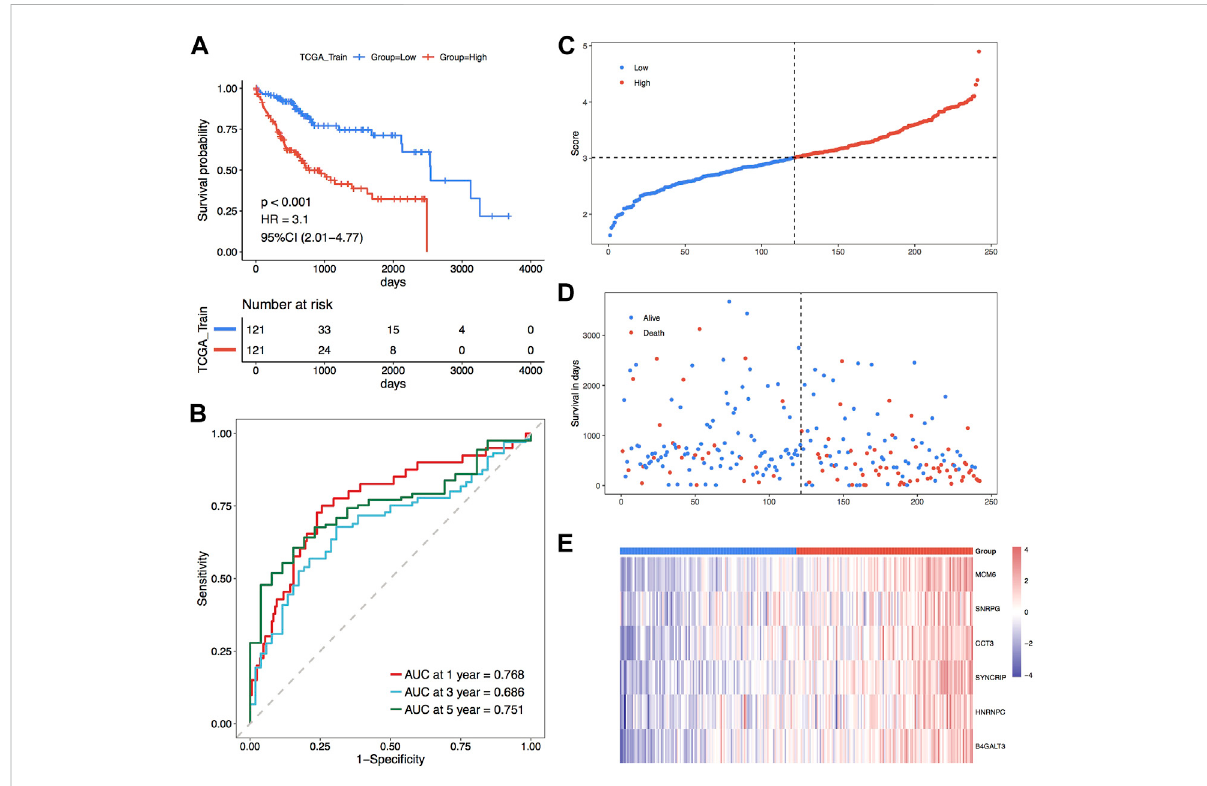
FIGURE 5 TCGA training set for the validation of the model ’ s prognostic ef fi cacy. (A) KM curve of TCGA training set; (B) ROC curve; (C – E) Risk triple-plot, including scatter plot of risk score, scatter plot of survival time and thermographic of model gene expression in risk score grouping, red highlights high-risk group and blue highlights the low-risk